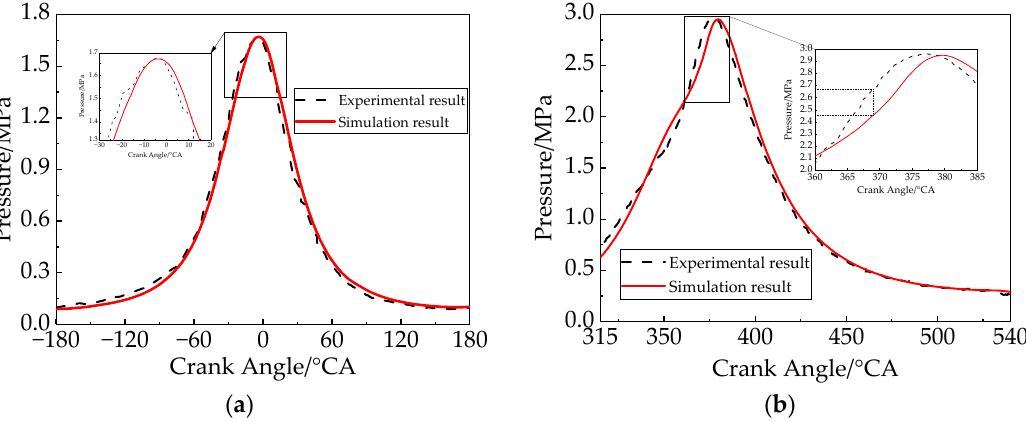
Figure 5. Pressure verification of experimental and simulation results: ( a ) pressure comparison between intake and compression processes at 10,000 RPM, ( b ) pressure comparison in combustion process at 9000 RPM.